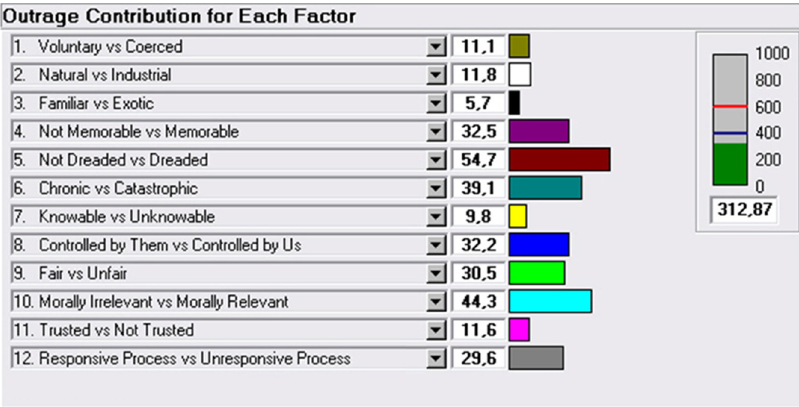
Figure 4. The contribution of each factor to the outrage management score obtained.